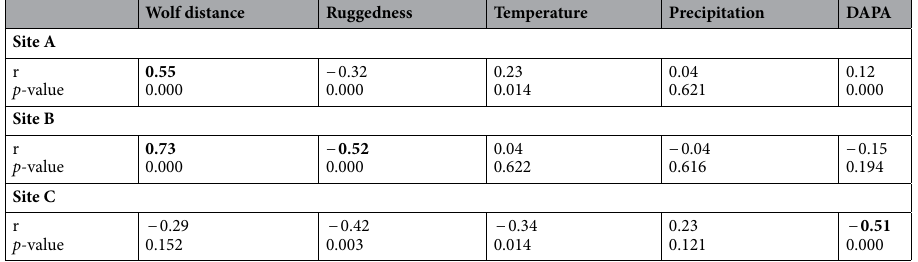
Table 2. Spearman’s simple correlation between the OPLS-DA scores of cow fecal extracts and external variables influencing the global metabolism of cattle. Correlation values |r|≥ 0.5 with P- value < 0.05 are highlighted in bold text. Wolf distance is defined as the average distance of the closest wolf-cow GPS points in the 48 h prior to the deposit of the cow feces; ruggedness is the average ruggedness calculated from cattle GPS points in the 48 h prior to defecation; temperature and precipitation are the average daily temperature and precipitation calculated in the 48 h prior to defecation; 2,6-diaminopimelic acid (DAPA), that measures nutritional quality, is the relative quantity of residue of rumen bacterial fermentation 1–3 days prior to